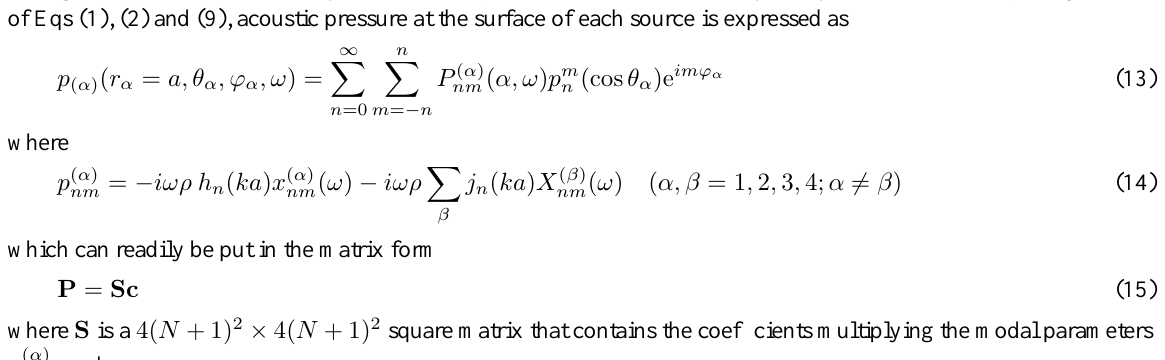
Fig. 4. Relative acoustic resistance for a pulsating and an oscillating source placed near the rigid boundary of an acoustic quarterspace at d 2 = a as a function of the separation parameter, kd 1 , at selected excitation frequencies. through an acoustic radiation impedance matrix, is determined in a few simple steps as follows. First, using